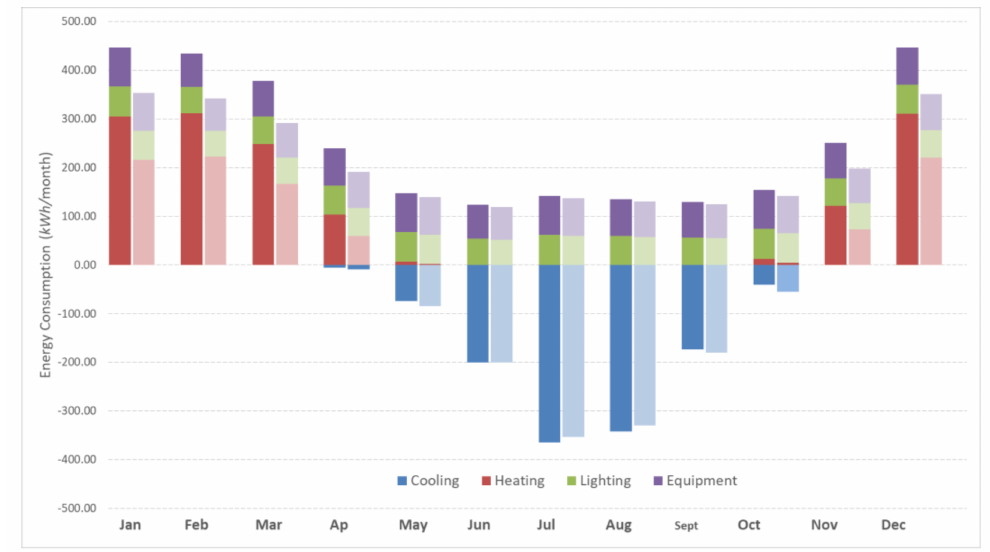
Figure 6. Energy needs before (scenario 0) and after (scenario 1) the placement of ETICS-like in Voula demo